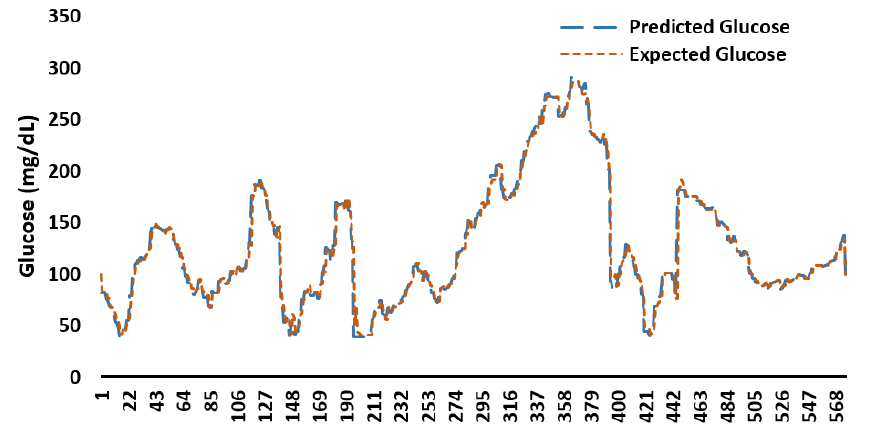
Figure A1. Comparison of expected glucose profiles with predictions from XGBoost trained on 30-day glucose data for 48 h.